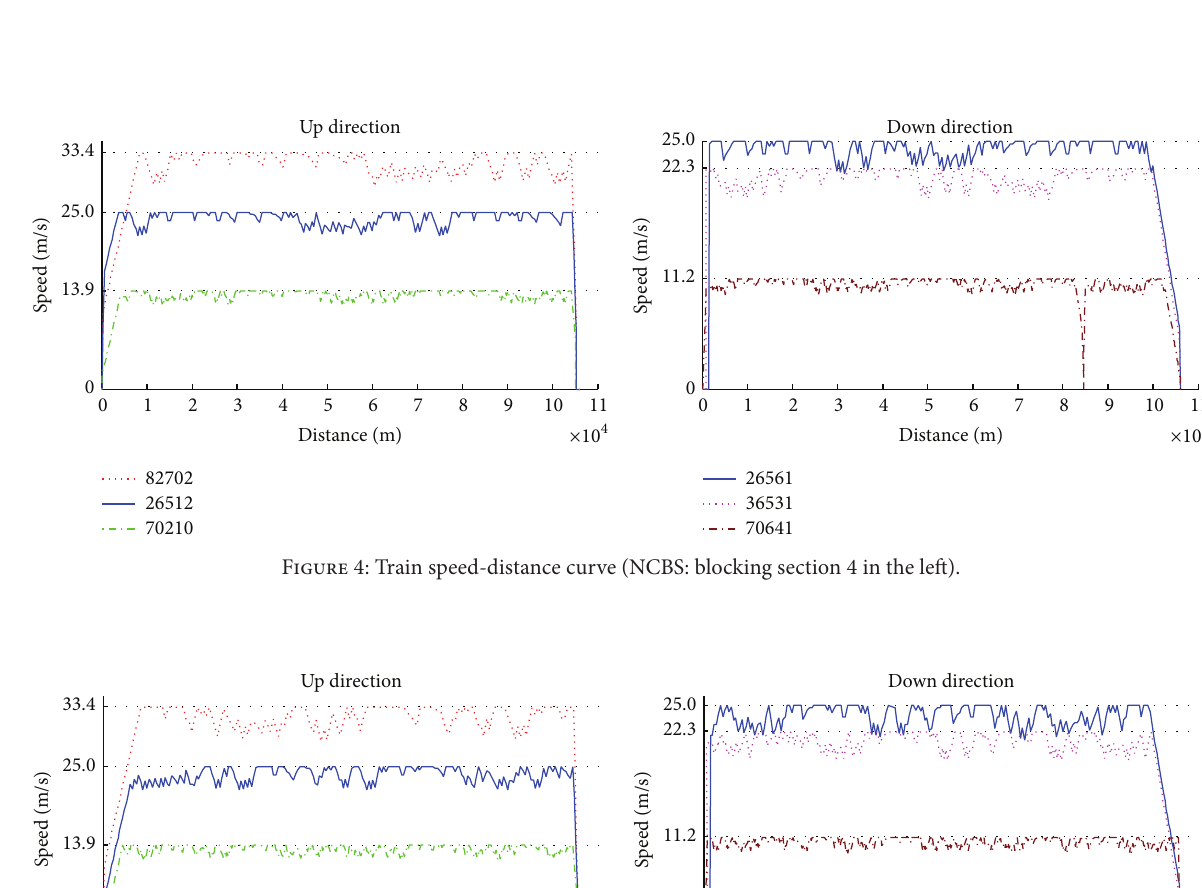
Figure 3: Train speed-distance curve (NCBSs setting: blocking section 3 in the left).